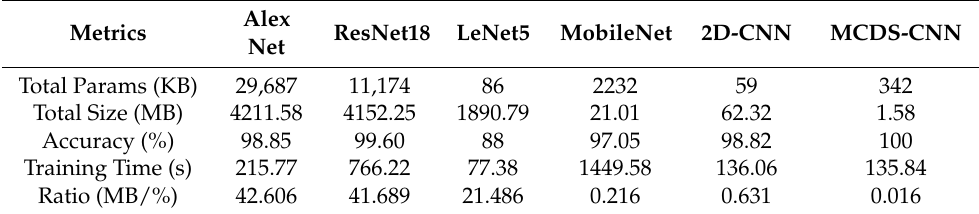
Table 7. Ratio and other performances of the proposed model, MCDS-CNN, and other five models on data set